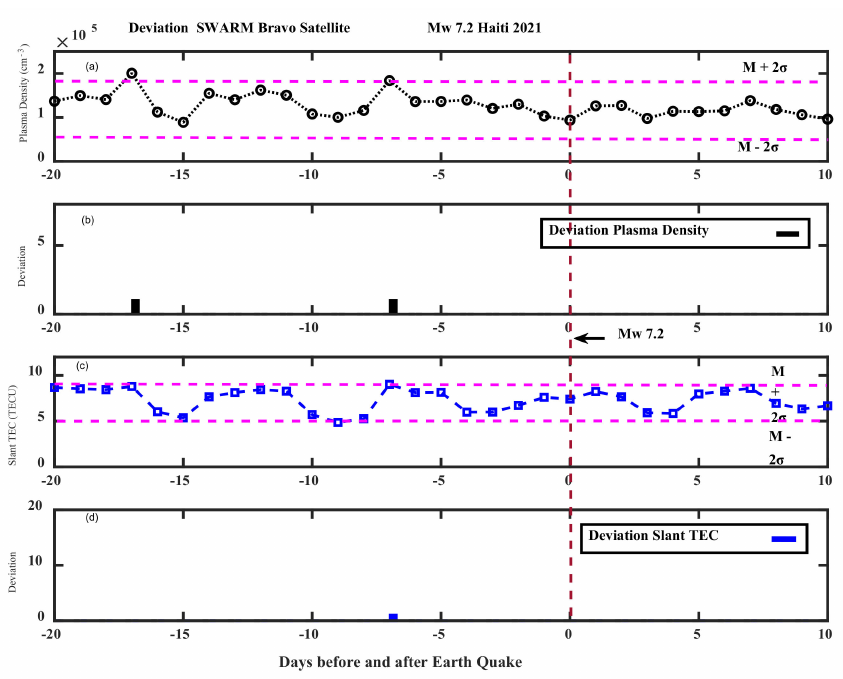
Figure 9. ( a ) plasma density, ( b ) deviation of plasma density as an anomaly, ( c ) STEC, and ( d ) devi- ation of STEC from upper and lower bounds of mean and standard deviation as an anomaly from Swarm-B for M w 7.2 (Haiti). The red dashed line represents the EQ